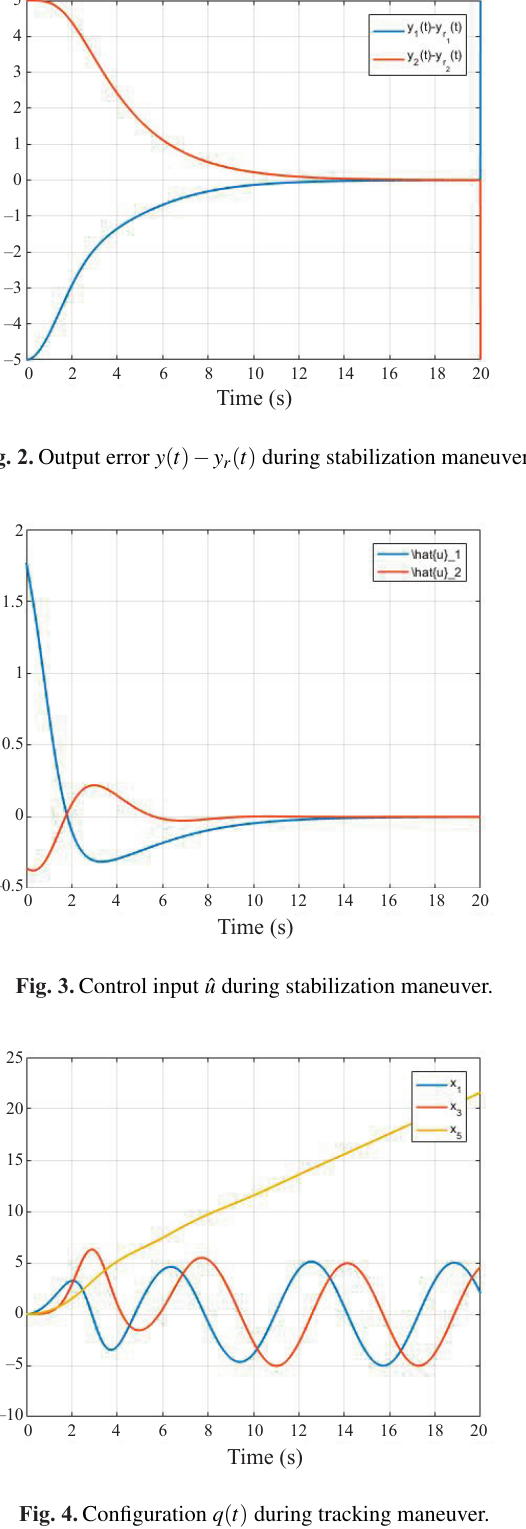
Figure 4. Configuration q ( t ) during tracking maneuver. Fig.